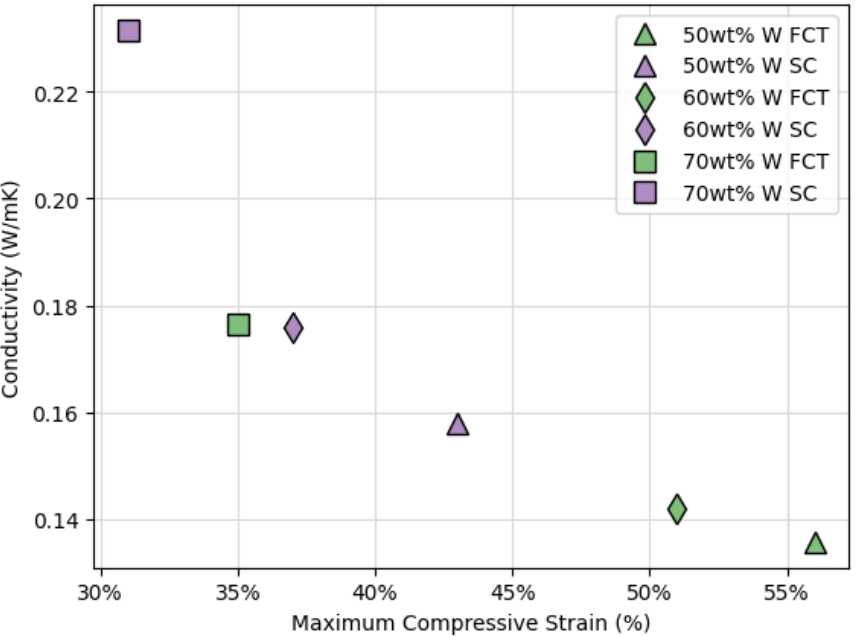
Figure 15. Thermal conductivity versus compressive strain of tungsten-filled DIW pads printed with FCT and SC lattice structures and 500 µm center-to-center strut spacing.